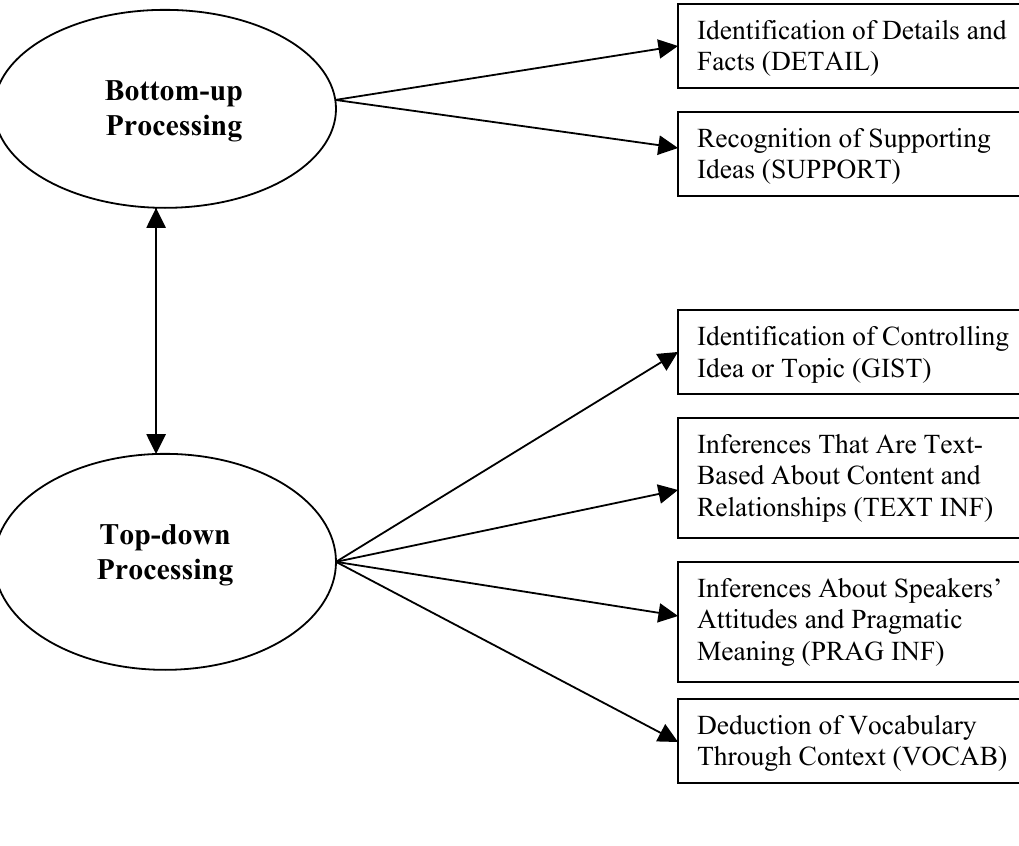
Identification of Details and Facts (DETAIL) Recognition of Supporting Ideas (SUPPORT)